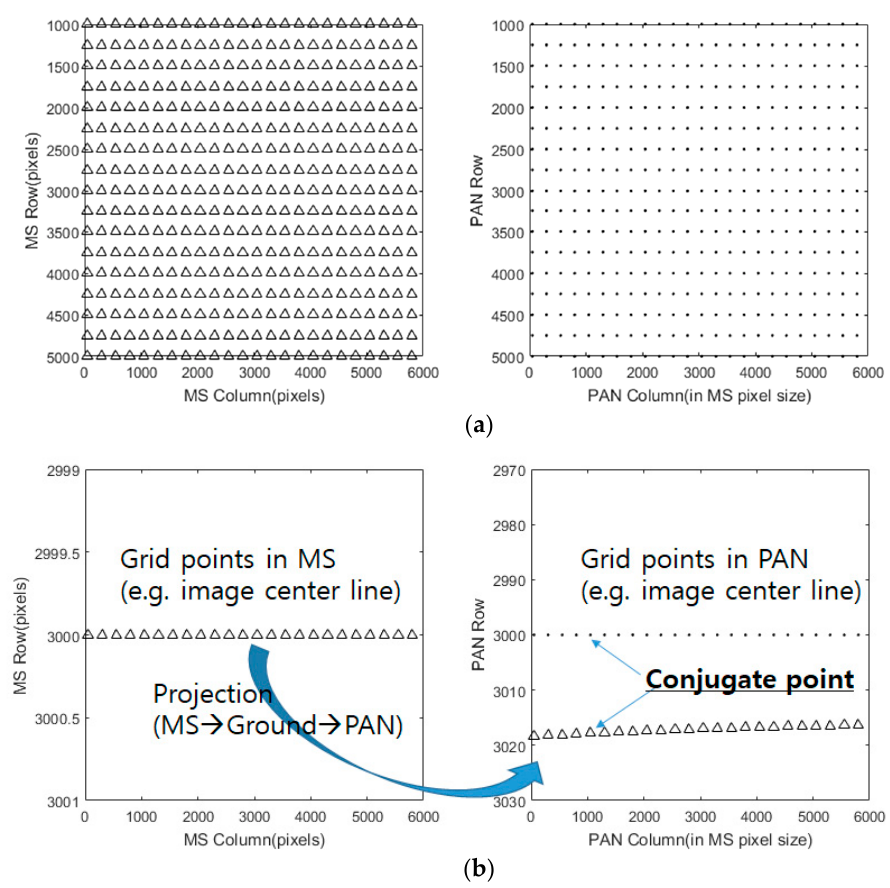
Figure 4. Grid points on MS and PAN ( a ) All grid points with interval 250 pixels in MS and PAN images and ( b ) the MS image center points and the corresponding PAN conjugate points via projection.